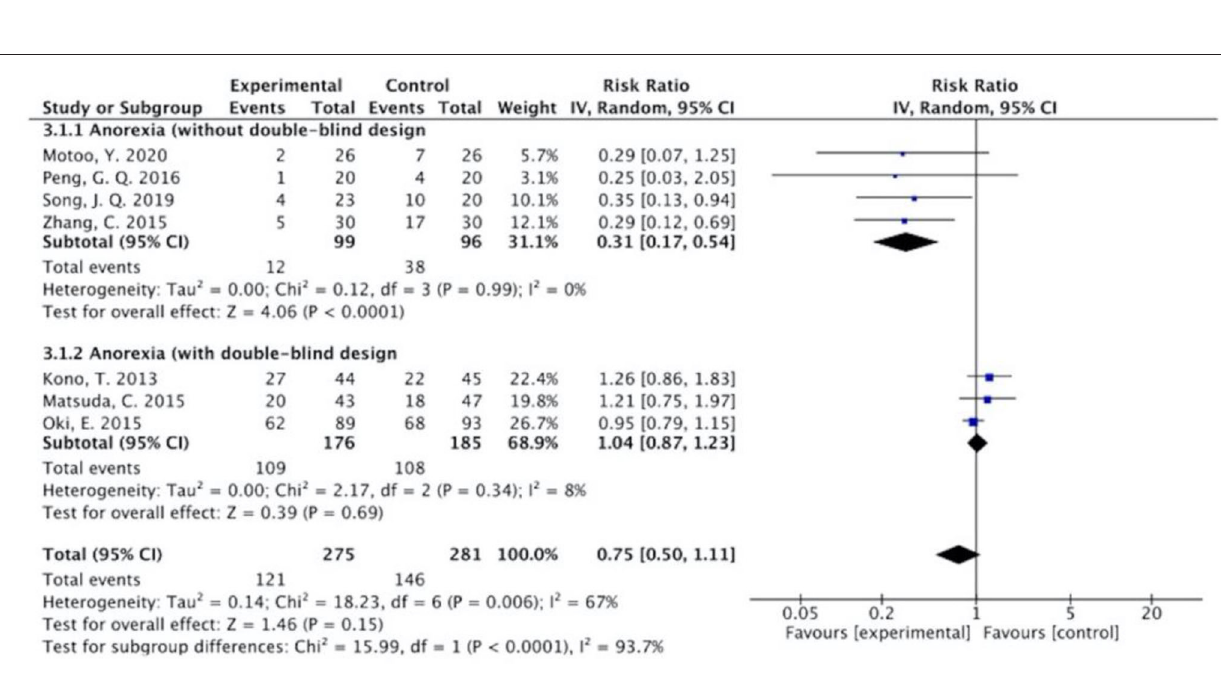
Frontiers in Oncology |